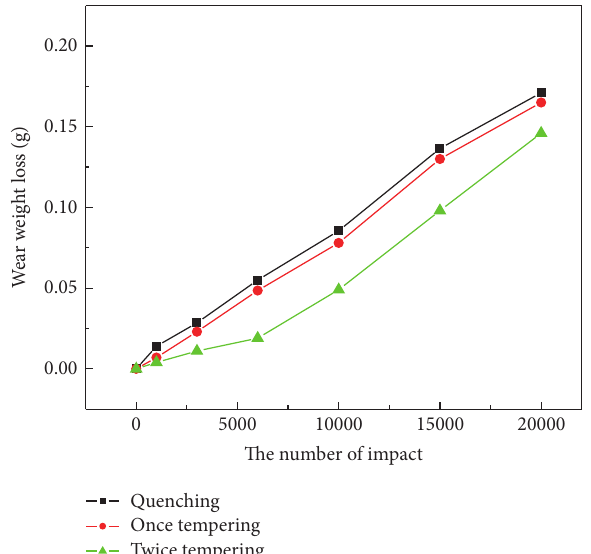
Figure 6: Weight losses of the specimens after different heat treatments.